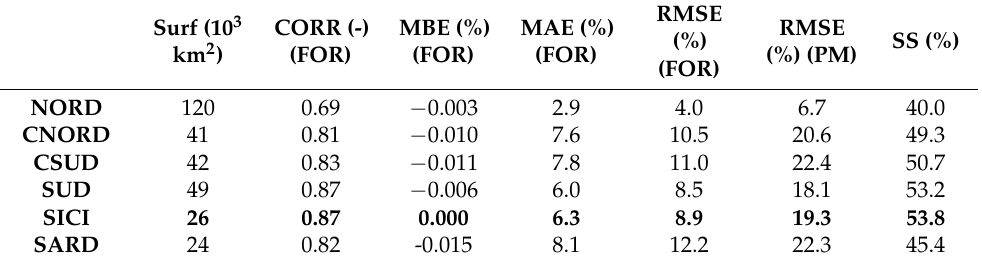
Figure 9. Scatterplots (forecast vs. observation) of the different forecasts used for the wind power prediction of the South zone (the zone with higher wind installed capacity). Table 4. Wind power forecast accuracy metrics of the ANN blend model (FOR), and the RMSE of the persistence forecast (PM) obtained on the six market zones. MBE, MAE, RMSE are in percent of the wind installed capacity. In bold is the area for which the greatest improvement over PM was